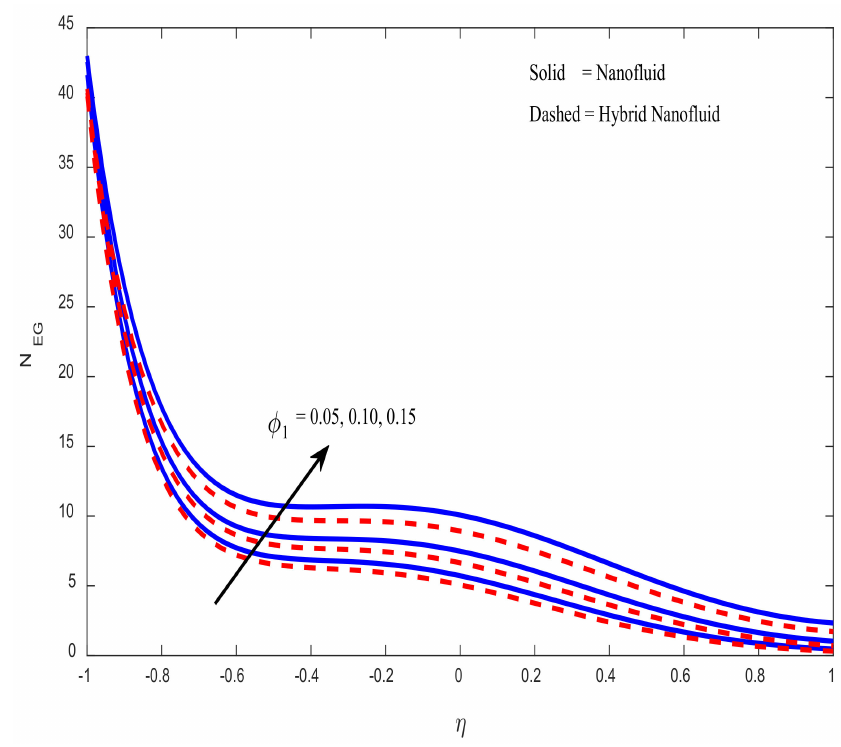
Figure 19. Influence of φ 1 on entropy generation